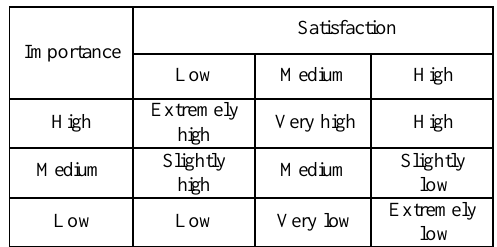
Fig.4. Technology Issues of